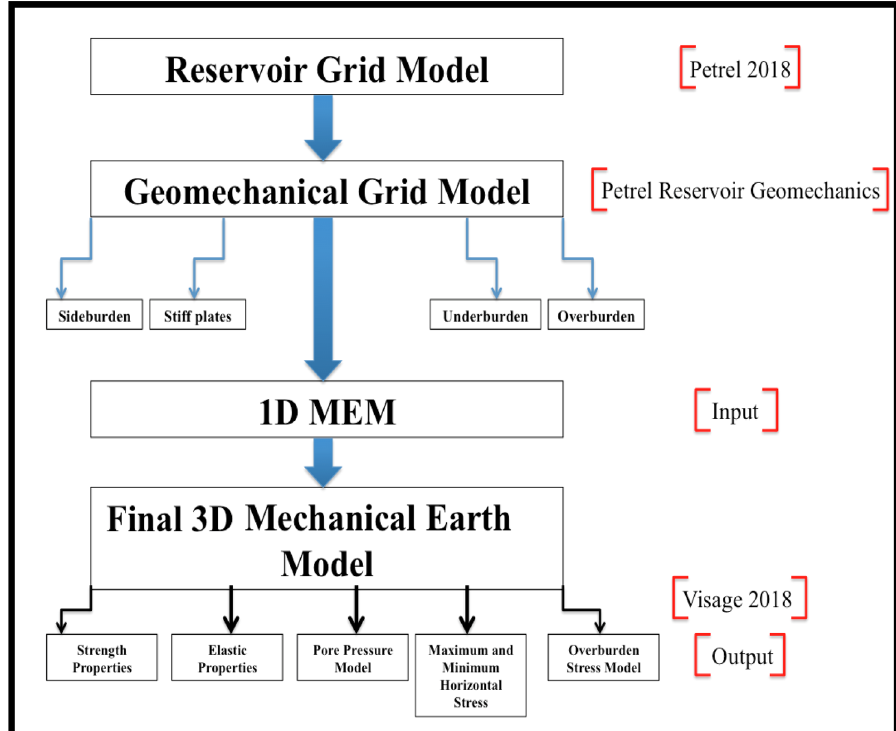
Fig. 4 3D MEM workflow chart